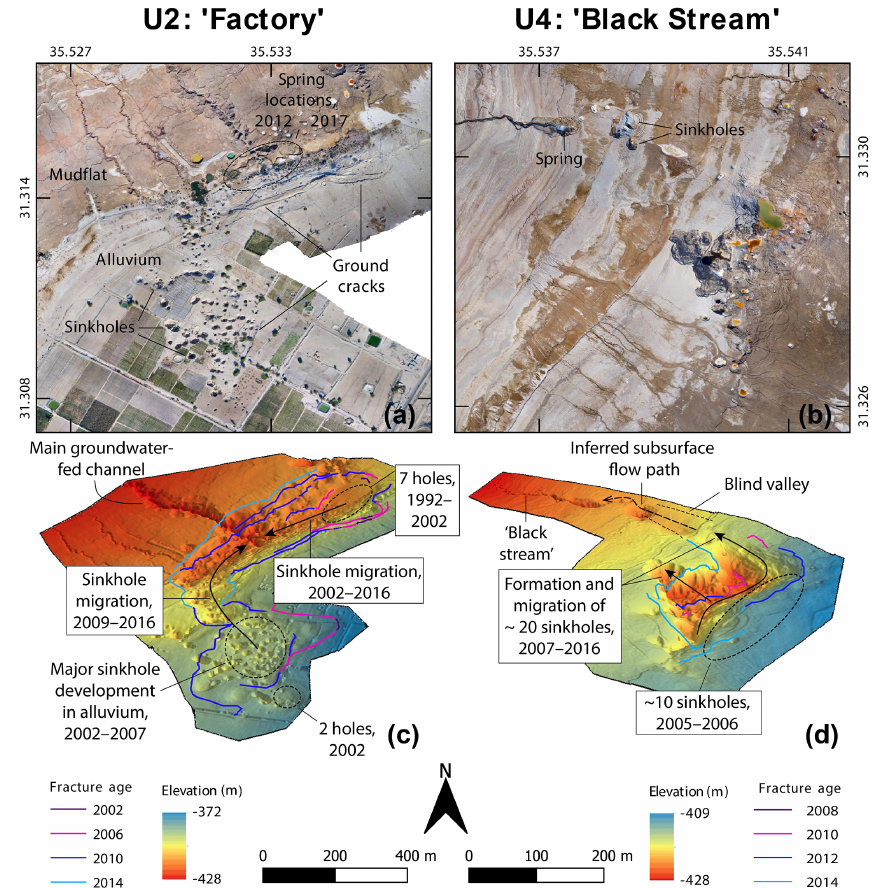
Figure 6. Structural development of uvalas with demonstrable connection to channelized subsurface water flow. See Fig. 4 for locations. Panels (a) and (b) show orthophoto images from 2016; Panels (c) and (d) show oblique 3-D views of the depressions derived from the 2016 DSM. The main depression-bounding fractures are shown, whose years of formation (i.e. when first visible in imagery) are grouped and coloured in 4-year intervals for U2 and in 2-year intervals for U4. Each uvala is linked morphologically to a highly active stream that emerges on the seaward side at several metres below the surrounding ground